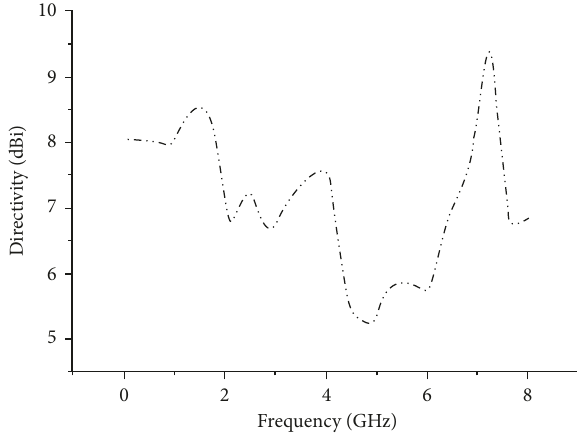
Figure 13: Directivity vs. frequency plot.